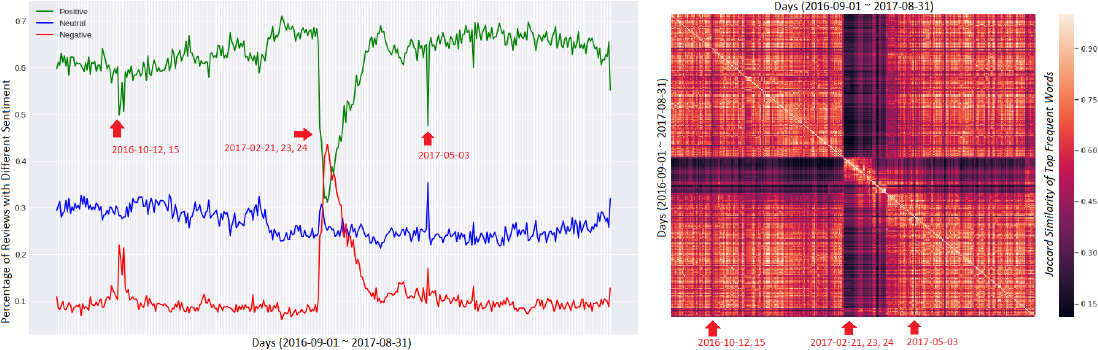
Figure 4. The identified abnormal days of Whatsapp as an example.